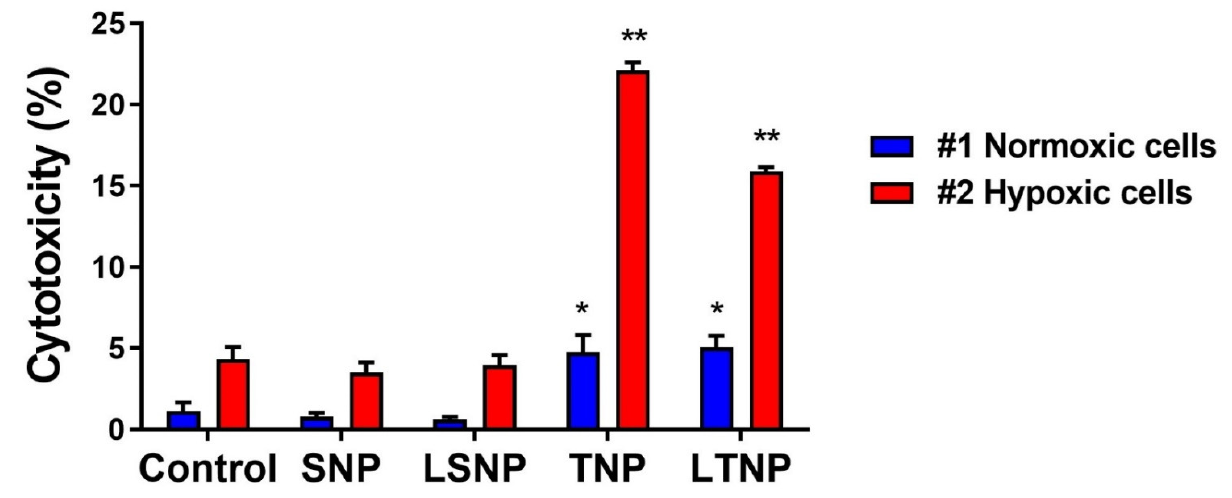
Figure 7. LSNP-induced cytotoxicity is inhibited by the interaction between metabolically conditioned tumor cells. C6 cells were cultured under normoxia and hypoxia for 3 weeks, normoxic cells (glucose 5.5 mM + lactate 32mM, blue bars) and hypoxic cells (glucose 25mM + CoCl 2 320 µM, red bars), and then co-cultured and treated with 100 µg/mL of nanoparticles for 72 h for the evaluation of cytotoxicity with propidium iodide staining. Bars show mean percentage of dead cells ± SEM of two independent experiments in quadruplicate, n = 8 (statistical analysis with one-way ANOVA after logarithmic transformation, * p < 0.001 and ** p < 0.0001 vs. their respective untreated controls).